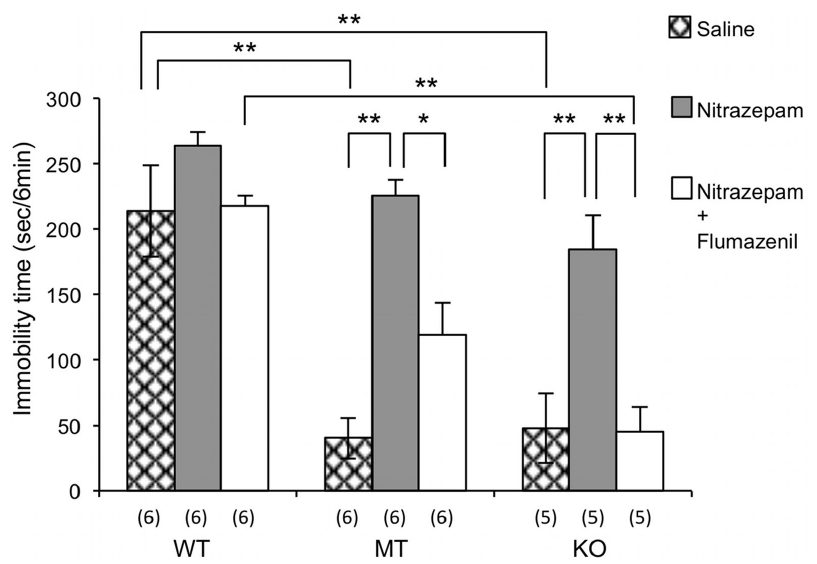
Figure 4. Effects of administration of nitrazepam and flumazenil on tail suspension test (TST) immobility time. Nitrazepam (1 mg/kg) causes a significant increase in immobility time in the TST, which was blocked by flumazenil (10 mg/kg) in both the Usp46 mutant (MT) and in the Usp46 KO mice (KO). In the wild-type mice (WT), no significant effects were observed with either single administration of nitrazepam, or co- administration of nitrazepam and flumazenil. Data are expressed as mean + S.E.M. for 5–6 mice in each group. * P , 0.05, ** P , 0.01 (two-way ANOVA with Bonferroni’s test).